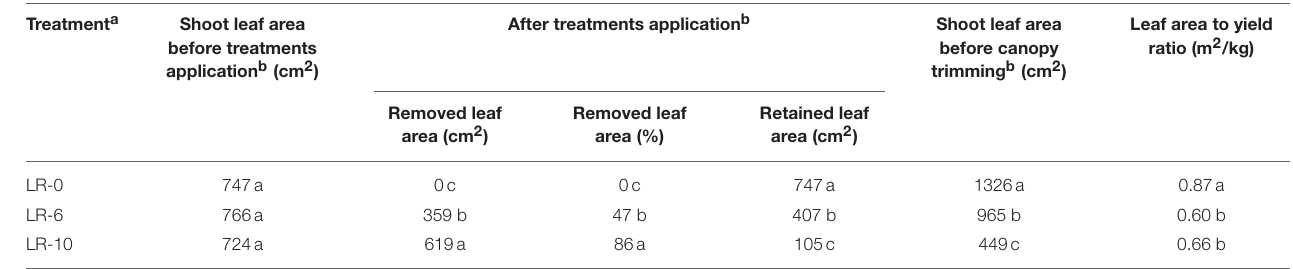
TABLE 1 | Impact of leaf removal on shoot leaf area and vine balance. Treatment